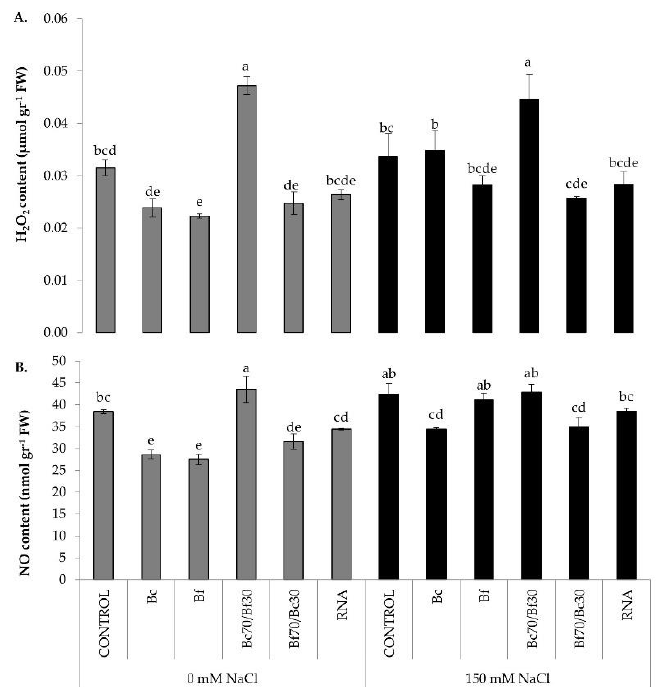
Figure 4. Effect of biostimulant treatments on RONS production, in control (0 mM) and salt-stressed (150 mM) conditions. ( A ) H 2 O 2 quantification, ( B ) NO quantification. Data are means ± SE of three replications. Bars with different letters are significantly different ( p < 0.05). Treatment abbreviations are explained in Figure 1.